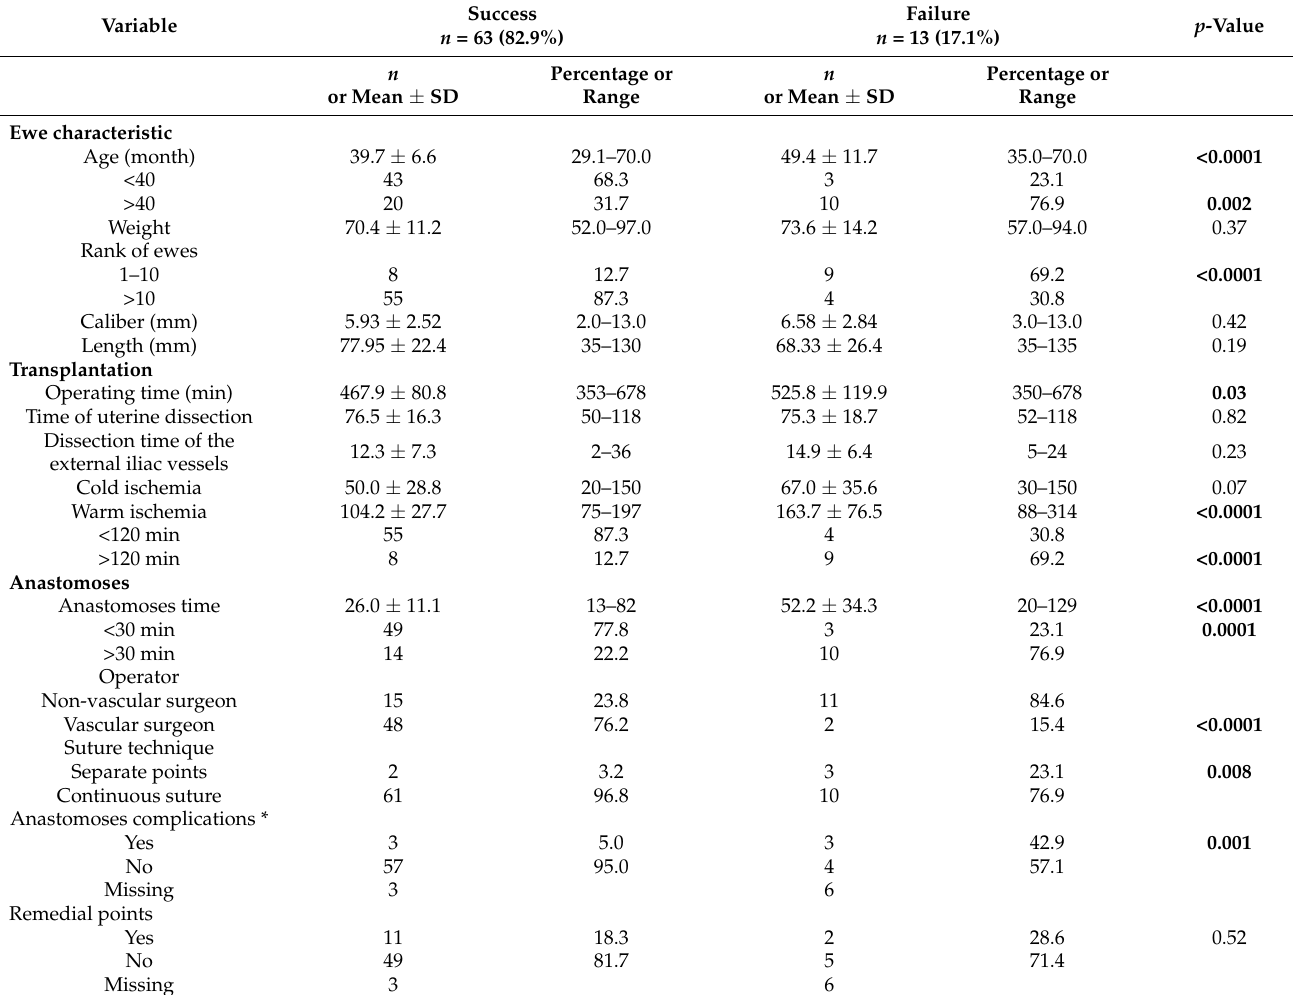
Table 2. Predictive factors for successful venous anastomoses in the immediate postoperative